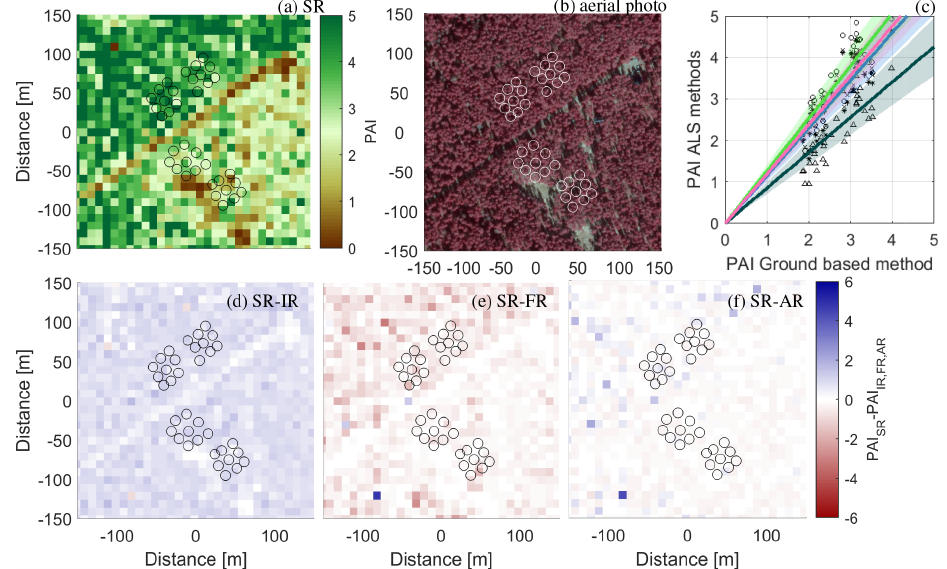
Figure 2. PAI evaluation at the Norunda site using a 10m × 10m grid: (a) the SR method; (b) an aerial photo (©Lantmäteriet) over the site, where the circles represent the placement of the ground-based observations; (c) a scatterplot of the hemispheric photo estimates and the ALS methods. The lines show linear regression forced through zero with shading indicating the 95% confidence level (1.96 times the standard error). SR is represented using the blue line and stars, IR is represented using the dark green line and triangles, FR is represented using the bright green line and circles, and AR is represented using the pink line and crosses. Panels (d) , (e) , and (f) show the difference between SR and the IR, FR, and AR reference methods, respectively.